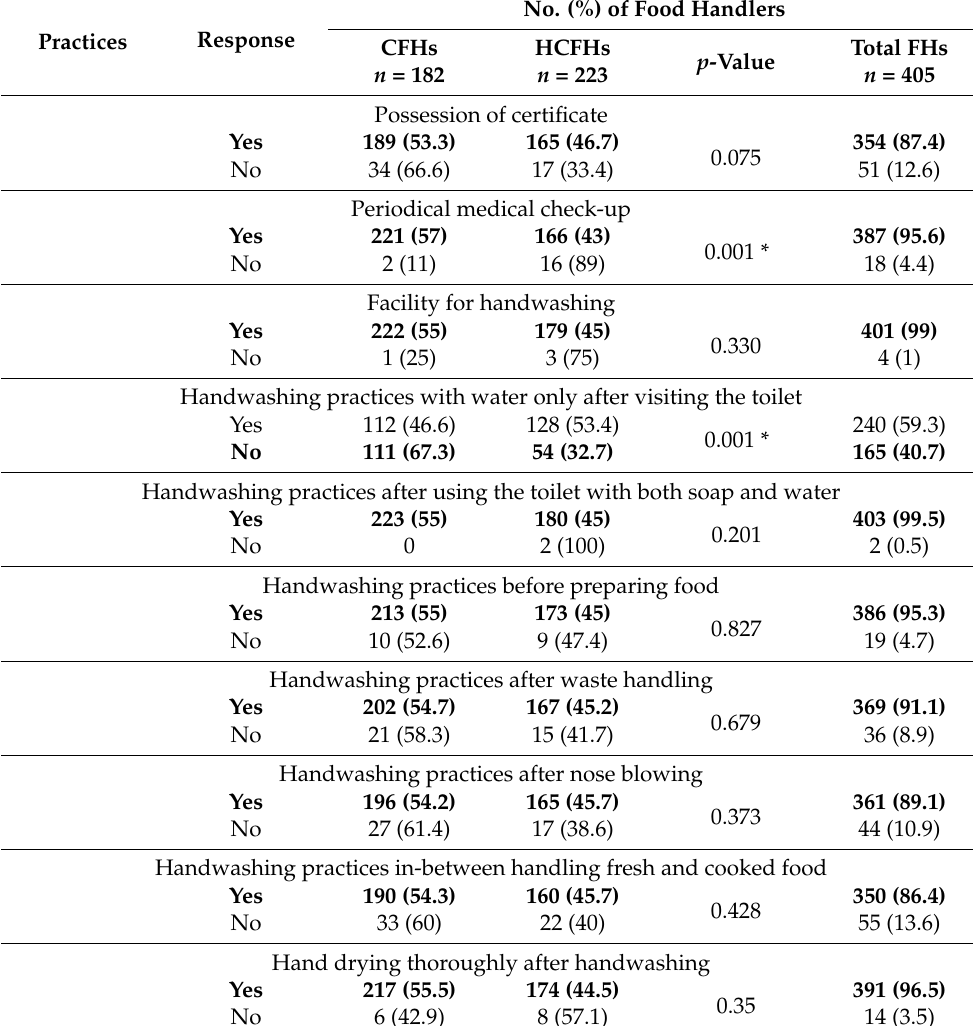
Table 5. Medicare practices and handwashing compliance assessment among healthcare and com- munity food handlers.